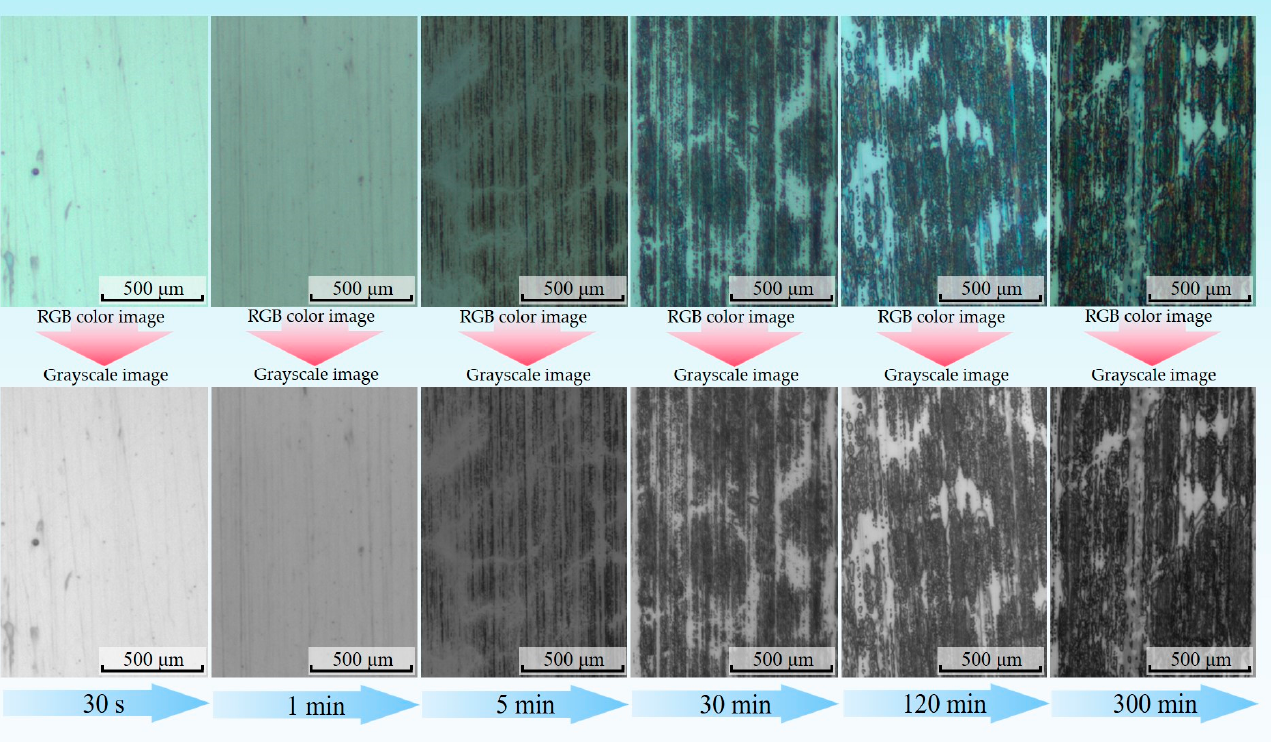
Figure 3. Greyscale image of the transfer film at different friction stages.